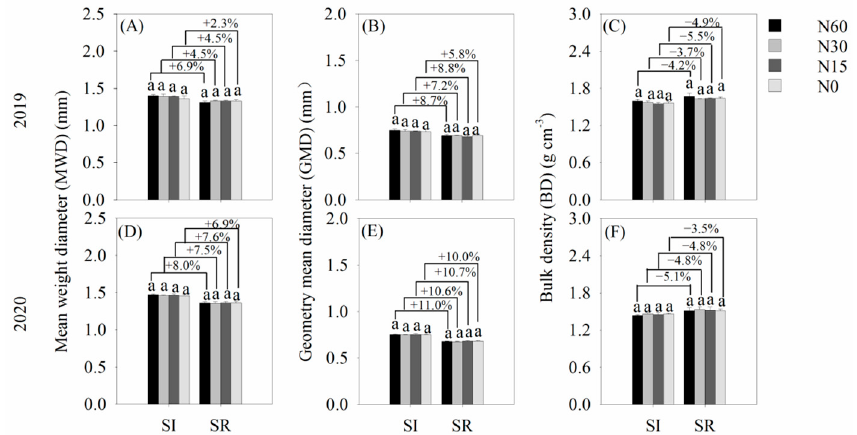
Figure 8. Soil macroaggregates stability and bulk density at the full maturity stage of soybean. ( A )